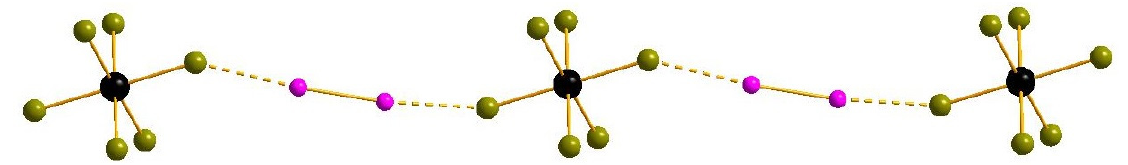
Figure 2. Linear {[SnBr 6 ](I 2 )} 2n − associates in the structures of 2 and 3 .